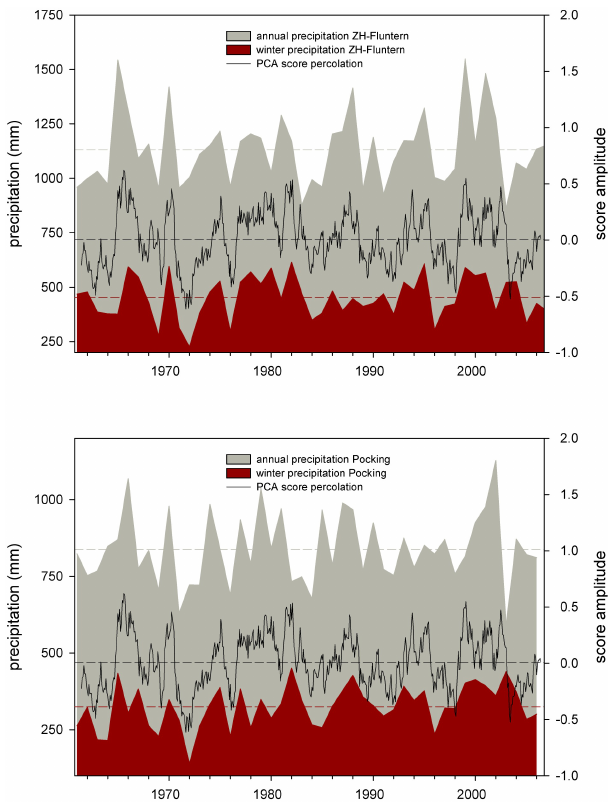
Fig. 9. Precipitation at the station Zurich-Fluntern (top) and Pock- ing (bottom) and the PCA score of the root zone percolation dur- ing the period 1961–2006. Dashed lines represent the yearly mean values of annual precipitation, percolation and winter precipitation during the